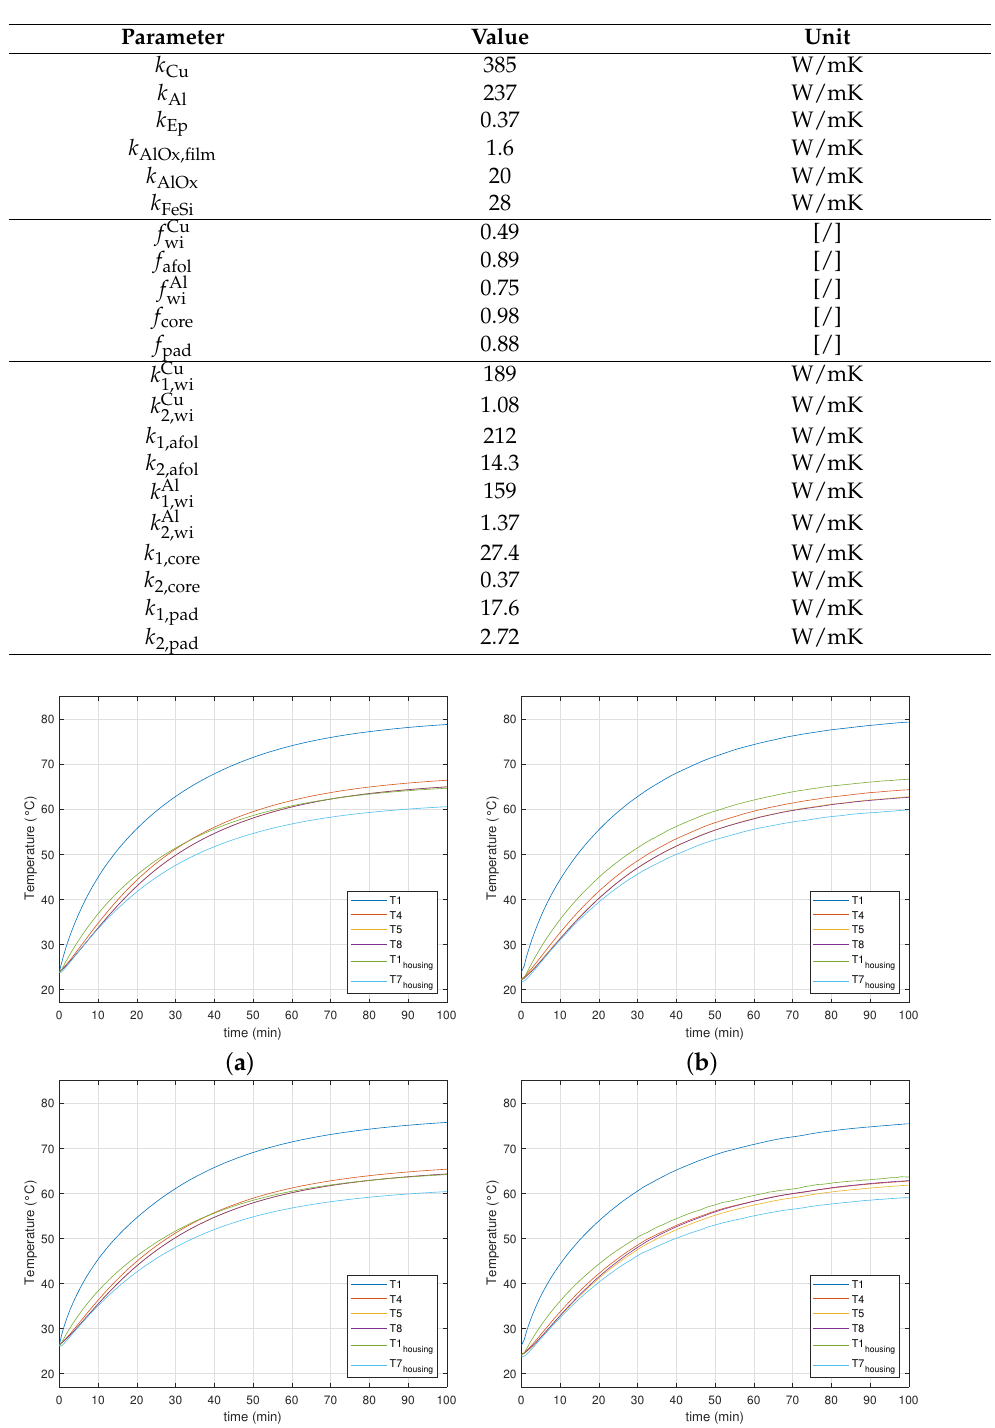
Table 4. Thermal Finite Element Model Parameters.